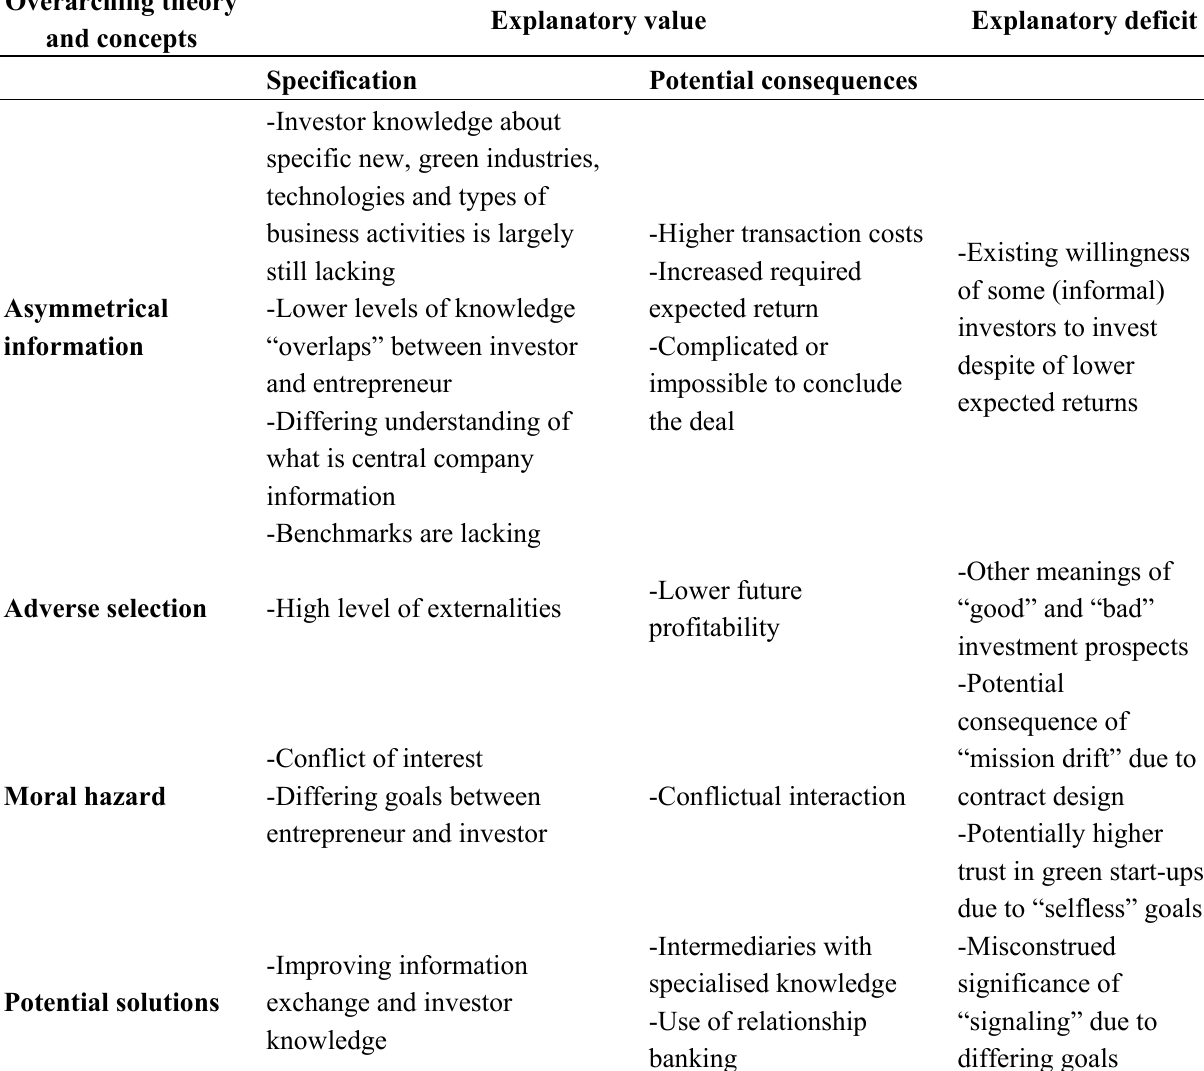
Table 1. Explanatory value and deficits of entrepreneurial finance theory for green start-ups. Overarching